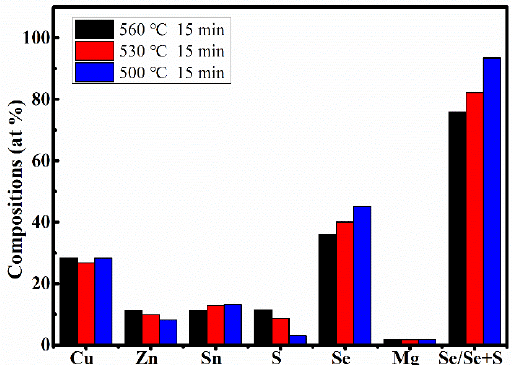
Figure 5. Energy-dispersive X-ray spectroscopy (EDS) composition analyses of CMZTSSe films annealed at different temperatures. Table 2. EDS results of the CMZTSSe films annealed at different temperatures from 500 to 560 °C. Sample